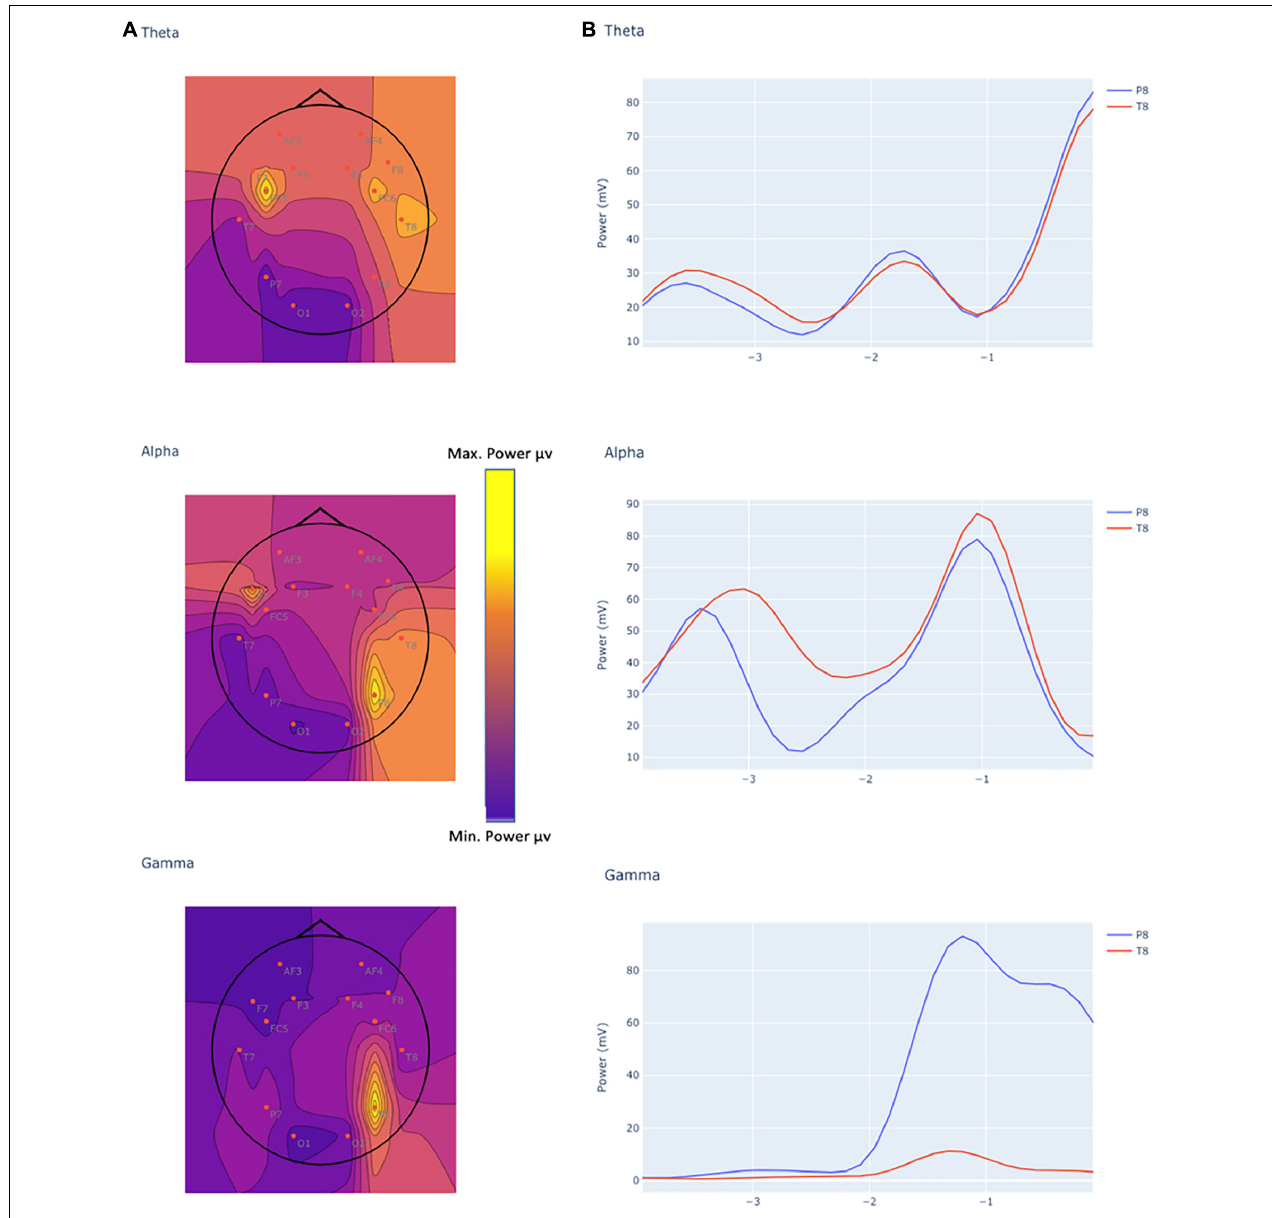
FIGURE 5 | Topographic distribution of scalp power to theta, alpha, and gamma frequency bands in the non-directive coaching condition (A) and EEG power wave form to alpha, theta, and gamma frequencies in the right temporal and parietal channels (B) . (A) Graphic showing the spatial distribution of theta, alpha, and gamma frequency bands in relation to their EEG power levels in the 4 s prior to the identification of insights by the subjects in the non-directive coaching condition. (B) Representation of the increase in power ( µ v) in the alpha, theta, and gamma frequencies in the right temporal (T8, red) and parietal (P8, blue) regions during the 4 s prior to the marker activated when one creative was identified by part of the subject.